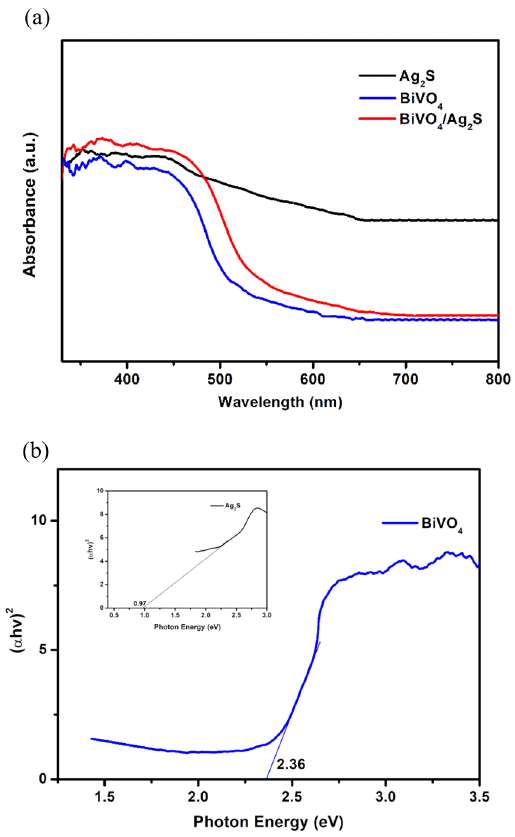
Figure 3. ( a ) UV-Visible diffuse reflectance spectra and ( b ) the energy band gap edges of Ag 2 S, BiVO 4 and BiVO 4 /Ag 2 S